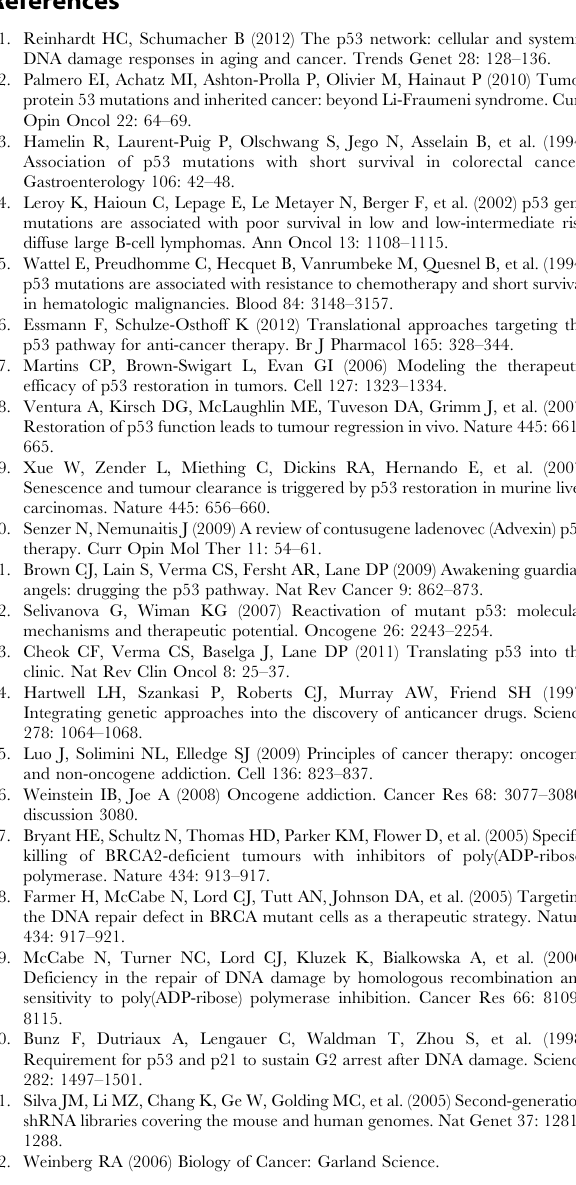
TERT and ETV1 levels in p53 + and p53 2 mouse embryo fibroblasts (MEFs) treated in the presence or absence of ETP46464. a -tubulin (TUBA) was monitored as a loading control. Table S1 List of 103 genes identified in the genome-wide RNAi screen for genes preferentially required for proliferation of p53 2 human cancer cell lines. Table S2 Summary of the cell culture results in Figure 1 and Figure 2. Table S3 Basis for the p53 2 status in each of the p53 2 cell lines used in this study.